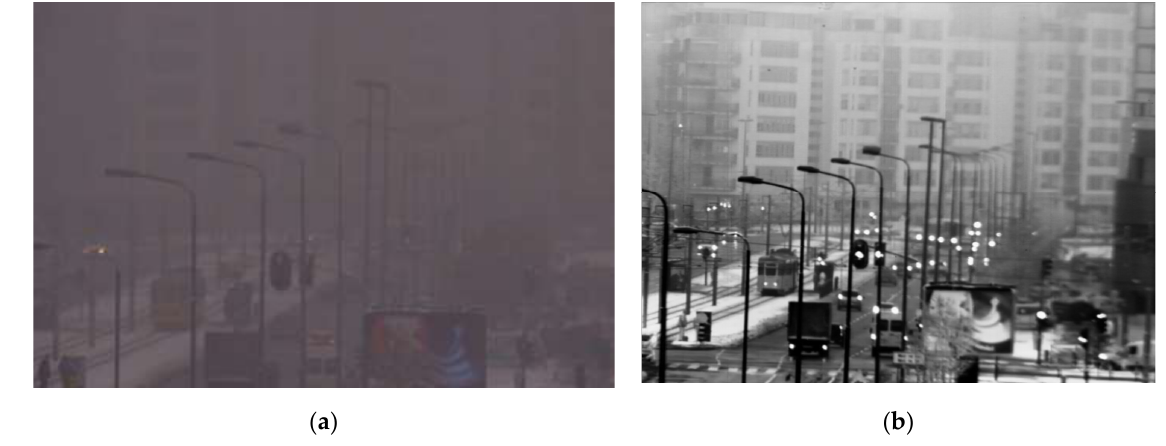
Figure 1. Image of a crossroad at distance of 1 km: ( a ) VIS, ( b ) SWIR. In Figure 2, images from VIS and SWIR camera show a building at distance of 4.3 km.